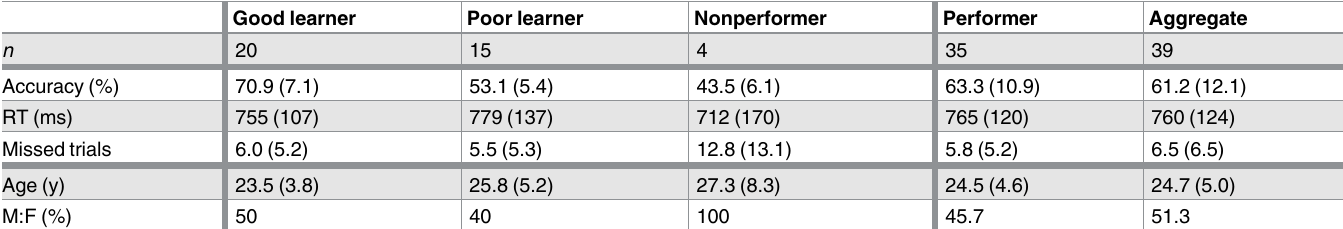
Table 1. Subject groups. Subjects were first objectivelydividedinto two groups a priori accordingto their performance on the task as representedby the accuracy score listed here. Of 39 total subjects, 20 were classifiedas “Good-learner” subjectsfor whom choice accuracy was significantly greater than the chance score of 50% at the level of an individualsubject ( p < 0.05). Of the remaining19 “Poor-learner” subjects, 4 were subsequently reclassifiedas “Nonper- former” subjects in cases of completeinsensitivityto outcomes, which was verified with computational modeling. There were no significantdifferences betweenthe two main groupswhen considering possibleconfounds in reaction time (RT), the total number of missed trials followingerrors, or age and gender ( p > 0.05). Standarddeviationsare listed in parentheses by the corresponding means within